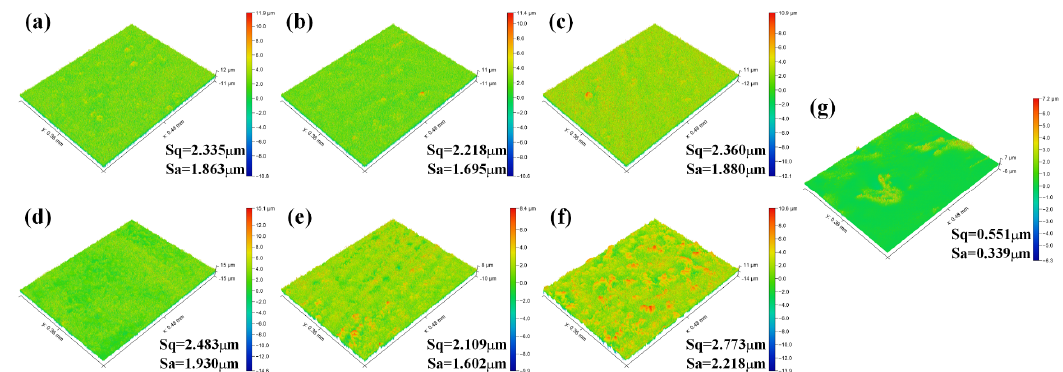
Table 2. SA of nano/microsilica-filled A-PDMS-modified epoxy coating ( R n/m = 8:2) at various temperatures (average with ± one standard deviation). Figure 9. 3D-Surface profiles and roughness parameters ( Sa and Sq ) of the nano / microsilica-filled A-PDMS-modified epoxy coatings: ( a ) R n / m = 10:0; ( b ) R n / m = 8:2; ( c ) R n / m = 6:4; ( d ) R n / m = 4:6; ( e ) R n / m = 2:8; ( f ) R n / m = 0:10. ( g ) A-PDMS-modified epoxy coating without silica.